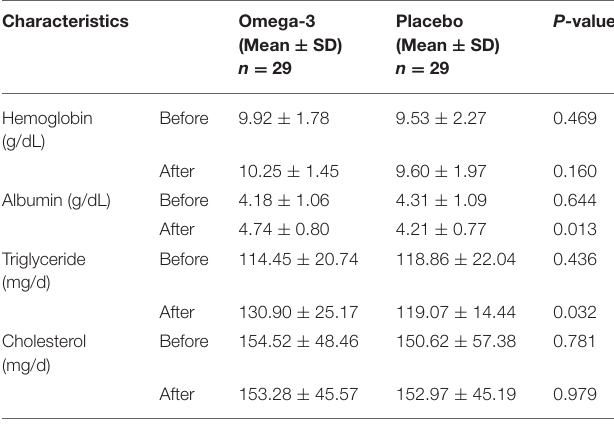
TABLE 3 | Laboratory indices of nutritional status with lung cancer in omega-3 fatty acid supplementation and placebo groups. Characteristics